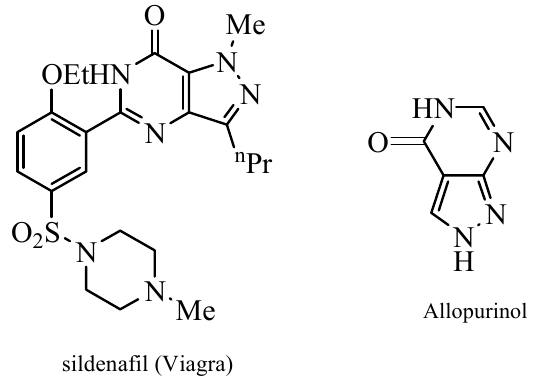
Figure 1. Structure of Viagra and Allopurinol.